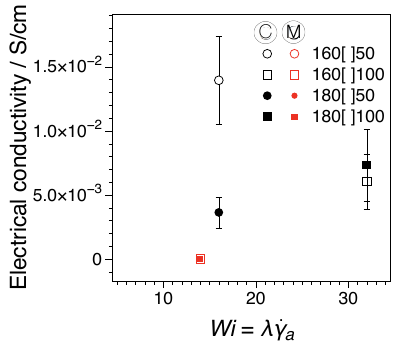
Figure 13. Conductivity in the circuit as a function of the Weissenberg number inside the extrusion die, Wi = λ ˙ γ a , of extruded strands before pelletizing and rheological characterization. Data processed from Arino et al.